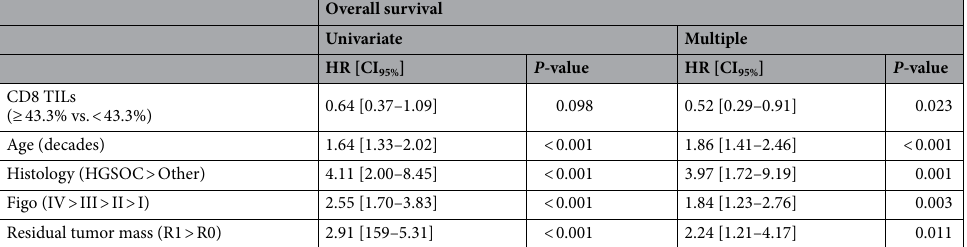
Table 4. Univariate and multiple Cox regression overall survival analyses for CD8 of TILs percentages in ovarian tissues. Combined hazard ratios and p-values for the dichotomized CD8 expression of TILs in univariate Cox-regressions (left) or multiple Cox-regressions, corrected for age, FIGO stage, and residual tumor mass (right). HR, Hazard Ratio; 95%CI, 95% Confidence Interval; OS, overall survival.